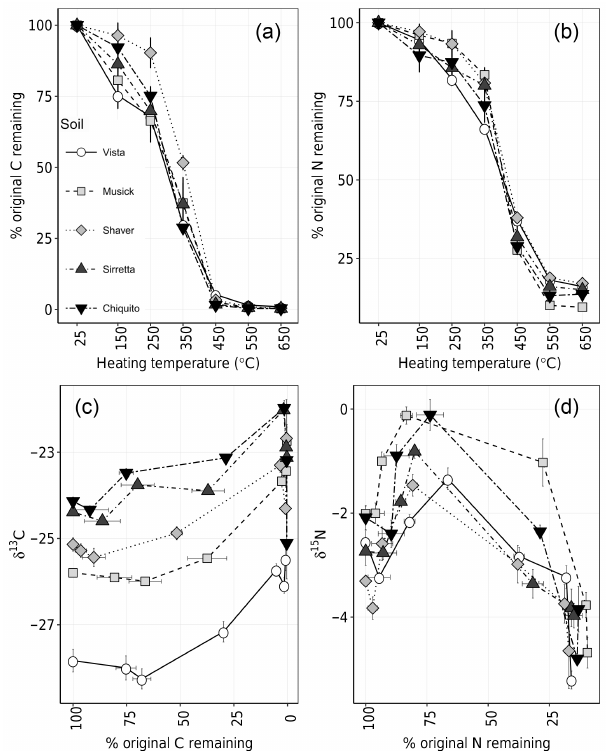
Figure 6. (a) Percentage of C and (b) N loss with heating, (c) change in δ 13 C, and (d) δ 15 N versus percent of total C and N lost from soils (error bars represent standard error, where n =